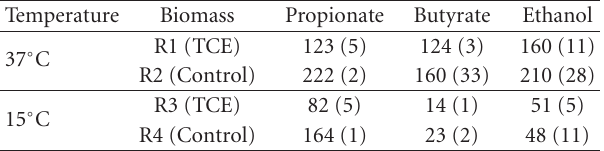
Table 1: Specific Methanogenic Activity (SMA) of biomass sampled from R1 to R4 on day 235 of bioreactor trial, when influent TCE concentrations of R1 and R3 were 60mg L − 1 [9] Values shown are expressed as mL CH 4 gVSS − 1 day − 1 and are means of triplicates with √ n , n = 3) given in std. errors (std. deviation/